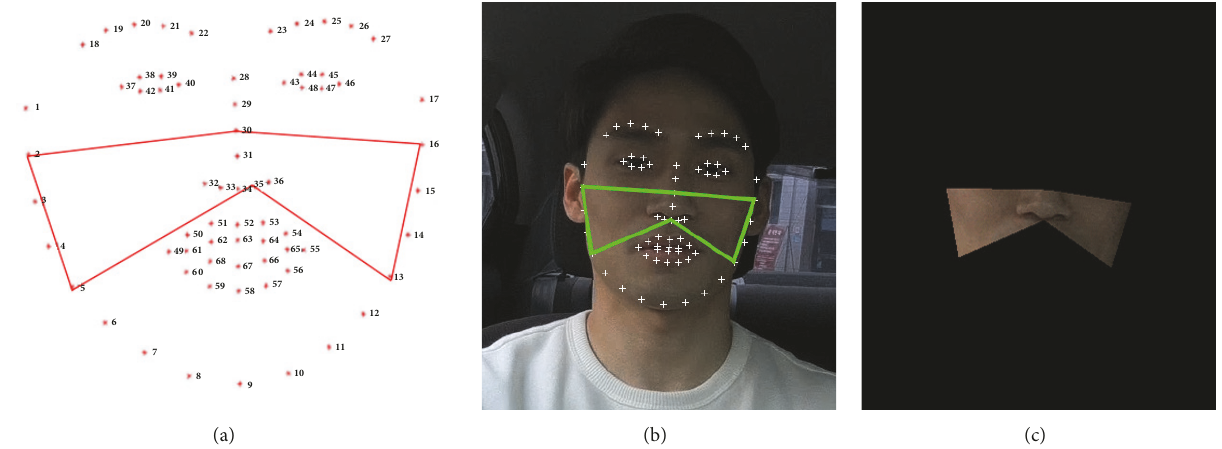
Figure 2: Extraction of facial landmark points. (a) The unique number of each of the 66 facial landmark points and the 6 selected points (4 contour points on the cheek and 2 points on the nose). (b) Detected result of the driving dataset. (c) Result of skin